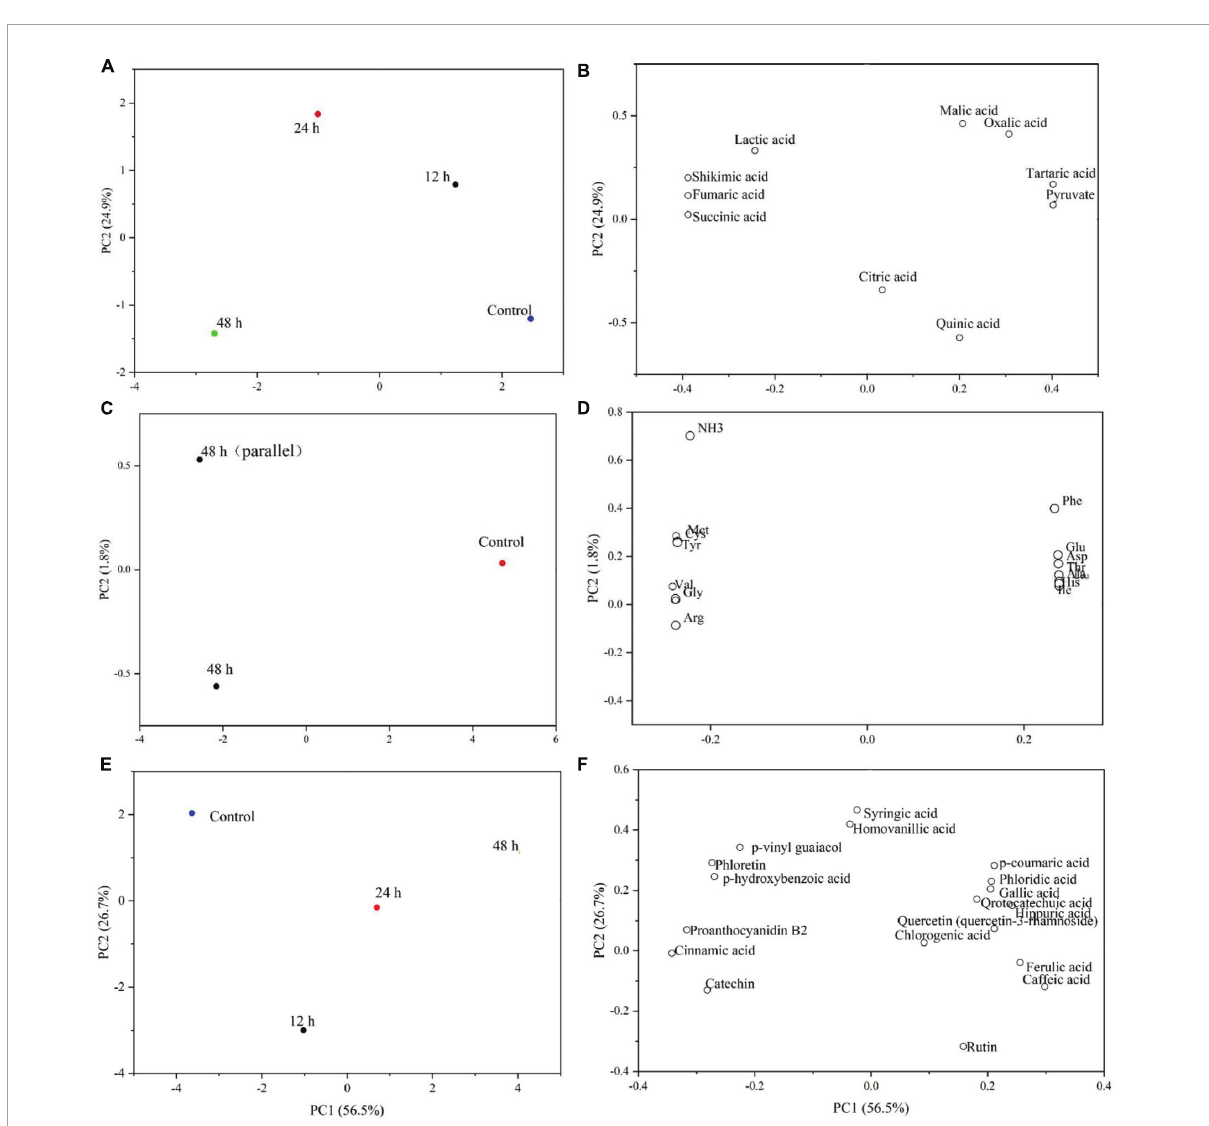
FIGURE3 Principal component analysis of changes in organic acids (A,B) , free amino acids (C,D) and phenolic acids (E,F) during fermentation of Ginkgo biloba kernel juice by Y2 for 48